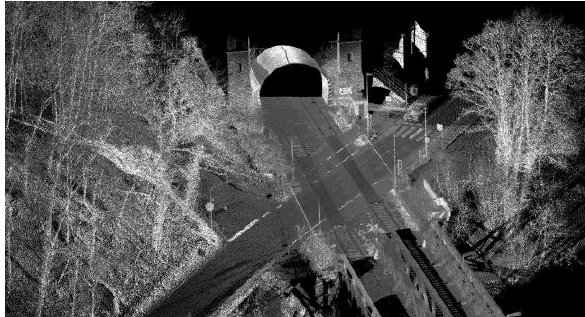
Figure 17: Point cloud of a railroad crossing